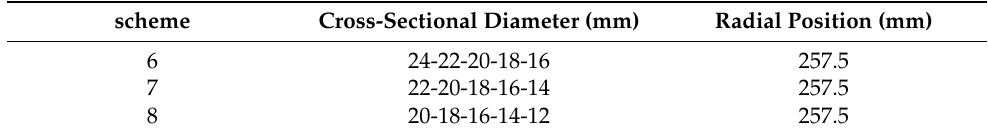
Table 3. Stator ventilation schemes with varying cross-sectional diameter.